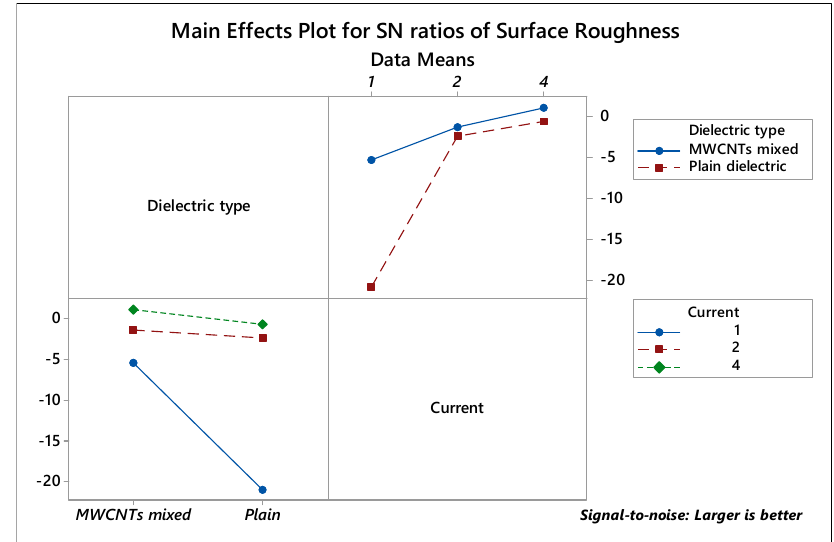
Figure 3. Main effects SN ratios plot of Surface Roughness.